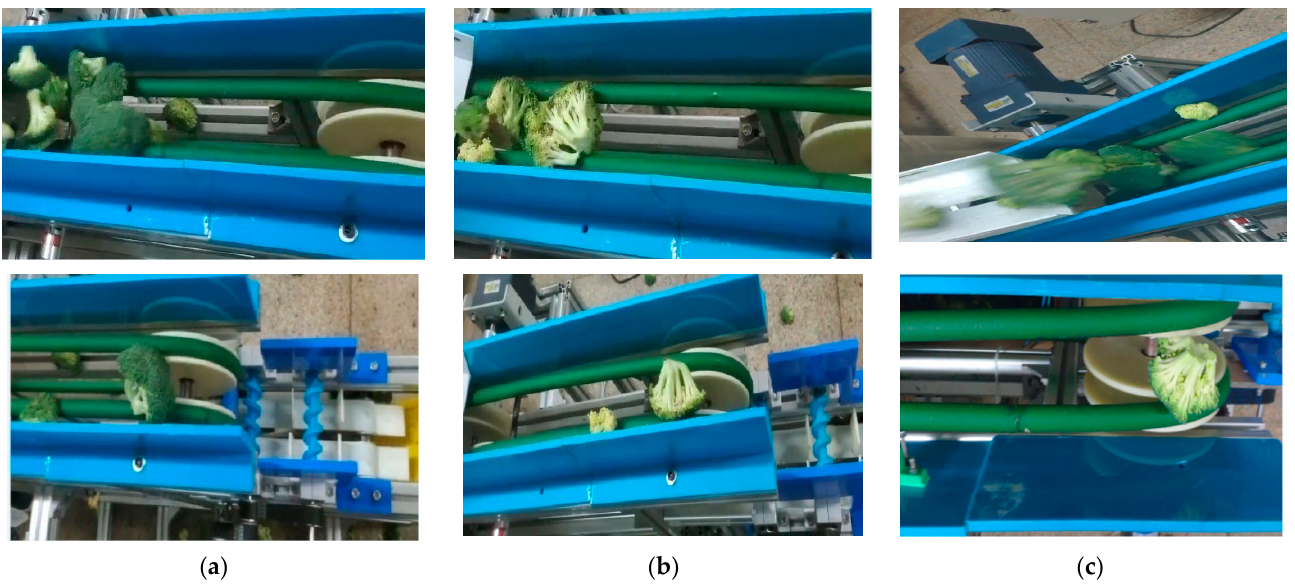
Figure 19. Large and small blocks stacked screening simulation analysis figures, respectively, the trajectory of two blocks and the distance and separation time of the center of mass of the two blocks moving in the direction of gravity: ( a – c ) correspond to 300:400, 300:500, and 300:600, respectively. The total number of blocks, florets, and unscreened florets were counted, and the screening success rate was defined as the ratio of the number of florets obtained by screening to the total number of florets, and the results of the experiment were recorded, as shown in Table 1. Screening results of blocks on differential speed belts with different speed ratios.